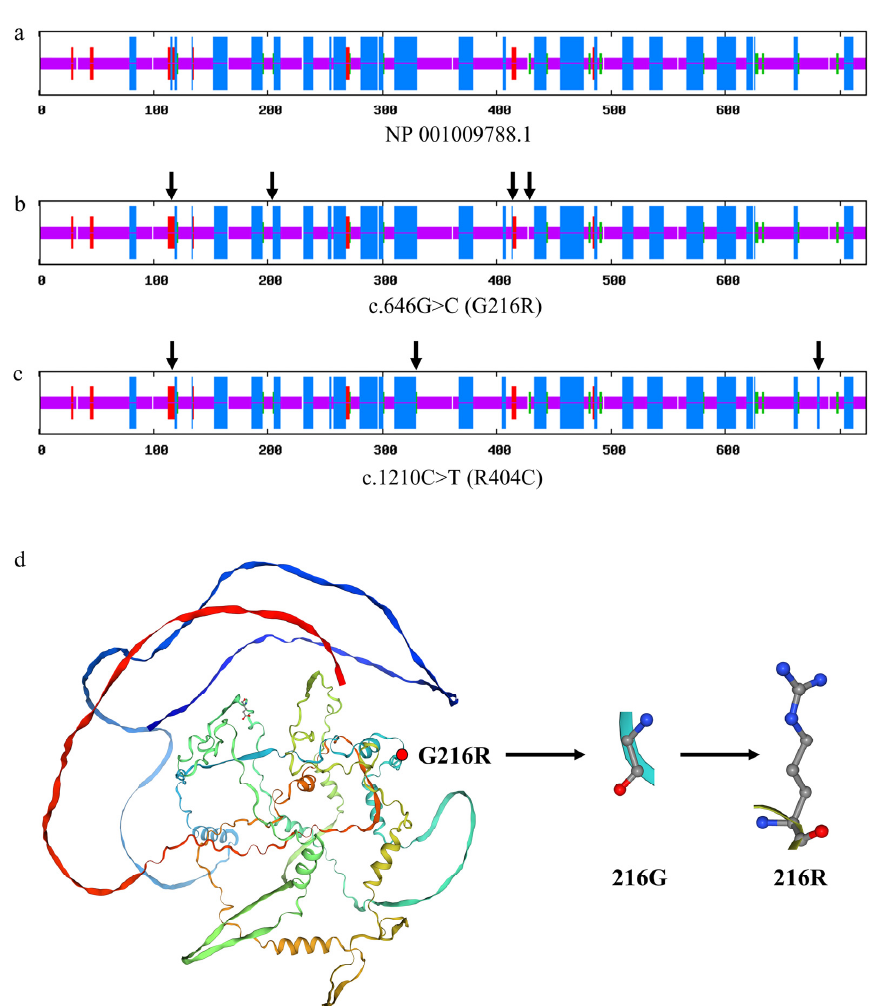
Figure 9. Secondary and tertiary structural changes of the ovine CAST protein. ( a ) Wild-type ovine CAST coding protein secondary structure. ( b ) The protein’s secondary structure changes when glycine changes to arginine at the c.646G>C (G216R) locus. ( c ) The protein’s secondary structure changes when arginine changes to cysteine at the c.1210C>T (R404C) locus. The long blue vertical line represents the alpha helix. The red line represents the extended strand. The short green line represents the beta turn. The purple line represents the random coil. The black arrow indicates where the secondary structure changes. ( d ) The prediction of ovine CAST tertiary structures. It was predicted that the amino acid change at the G216R (c.646G>C) site would cause visible changes in the CAST structure.